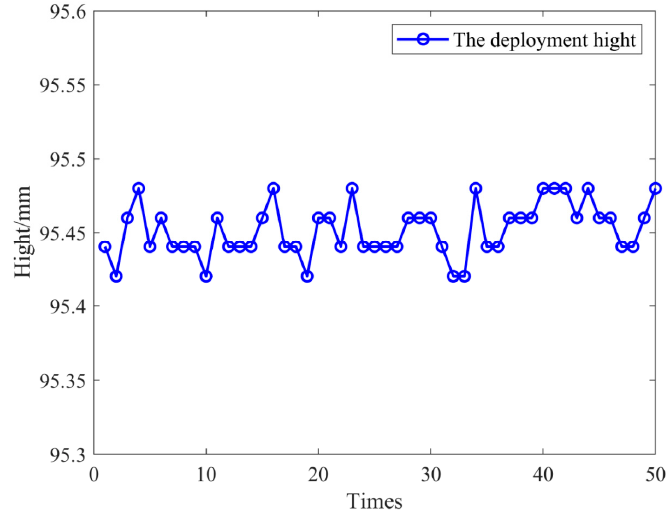
Figure 13. The practical deployment height of the deployable baffle at 50 times experiment.